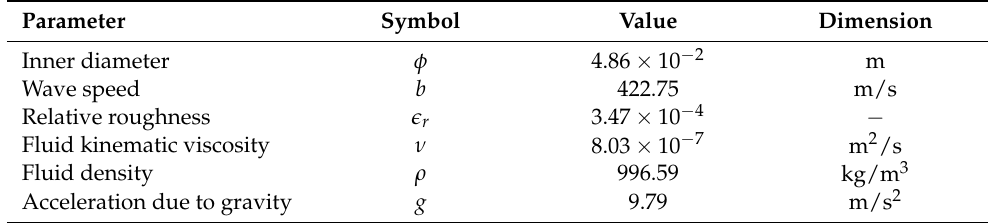
Table 1. Pipeline parameters.